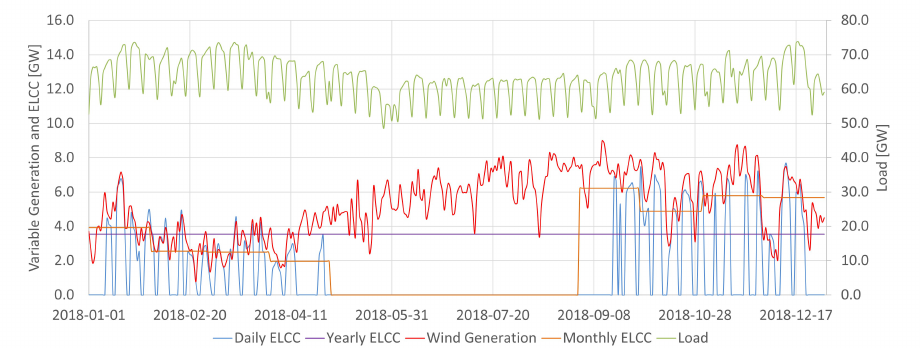
Figure 5. Daily, monthly and yearly ELCC for wind power in 2018 for the